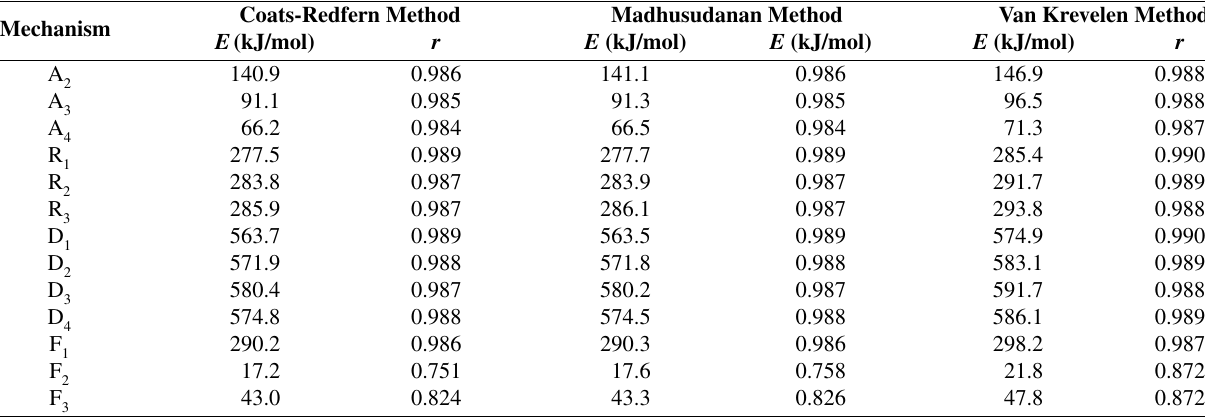
Table 2. Activation energies obtained for several solid state processes at a heating rate of 5 °C/min Coats-Redfern